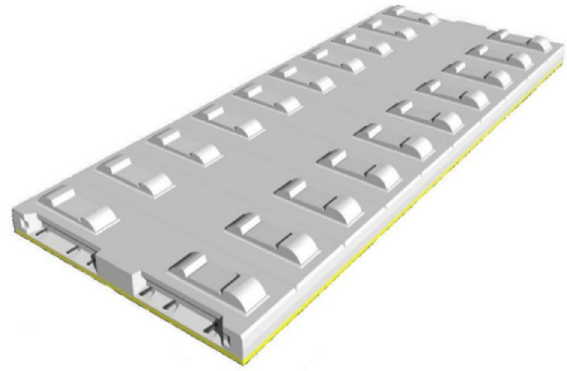
Figure 1. Schematic diagram of CRTS Ⅲ SBT.